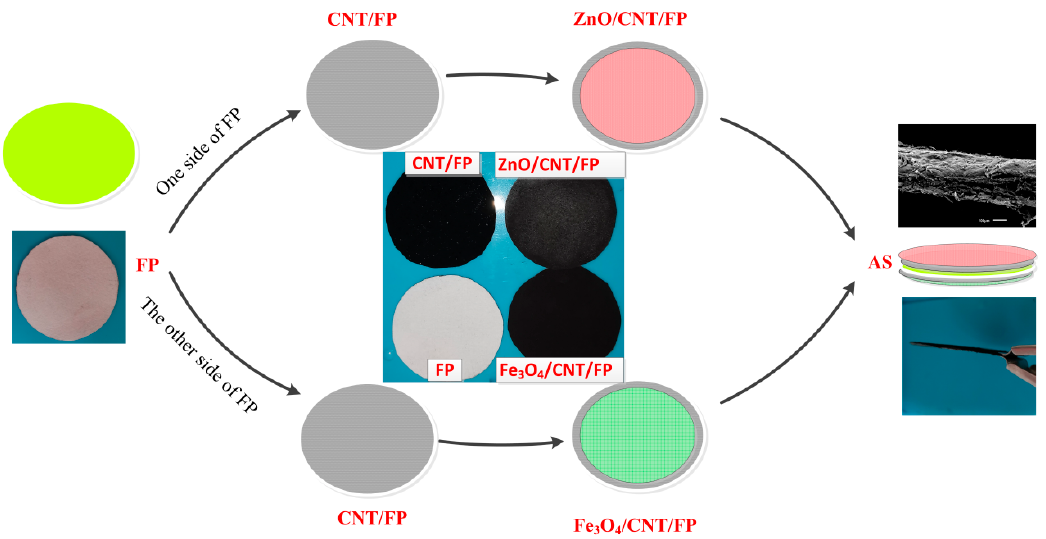
Figure 1. Schematic diagram of the preparing process of zinc oxide (ZnO) / carbon nanotubes (CNT) / filter paper (FP), Fe 3 O 4 / CNT / FP and asymmetric supercapacitors (AS) on one sheet of FP, respectively.